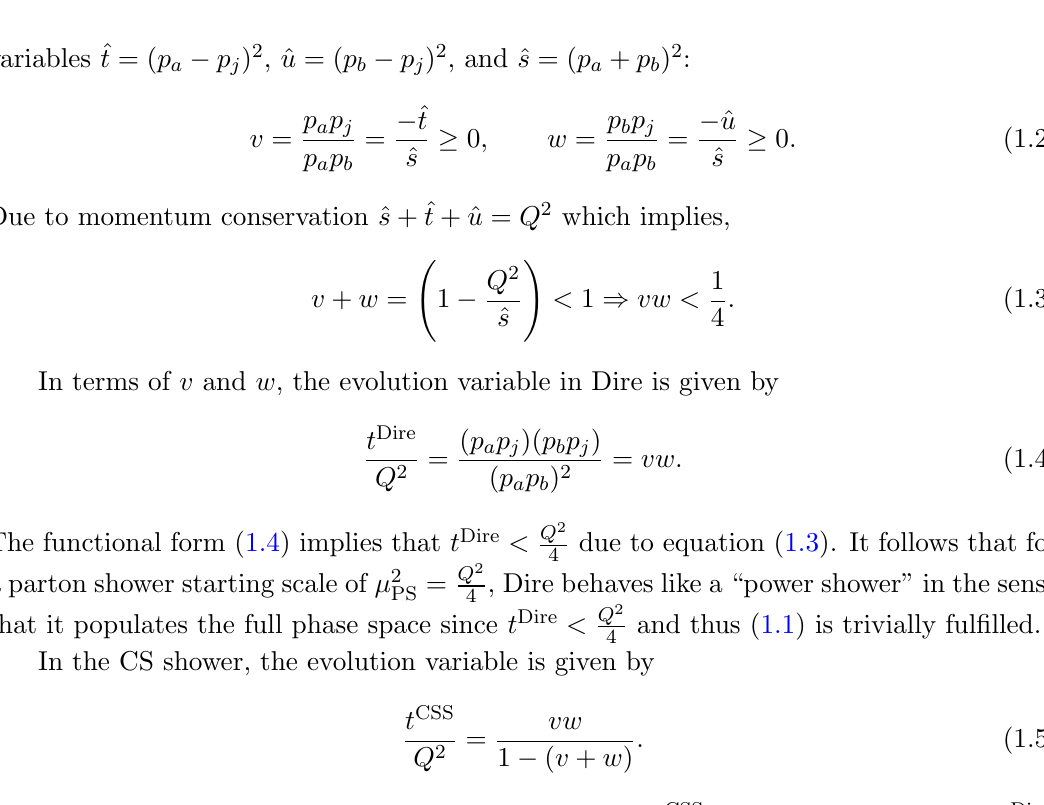
Figure 1 . De(cid:12)nition of kinematic variables in the (cid:12)rst